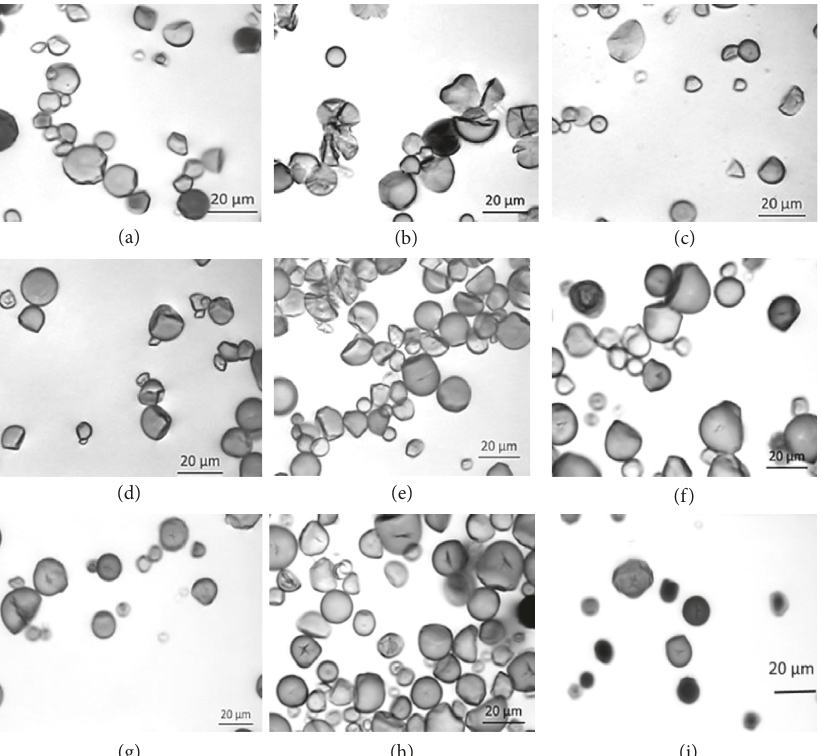
Figure 1: Optical microphotographs of native (a) and fermented modified potato starches (bar is 20 µ m): (b) AM-0.05, (c) AM-0.1,